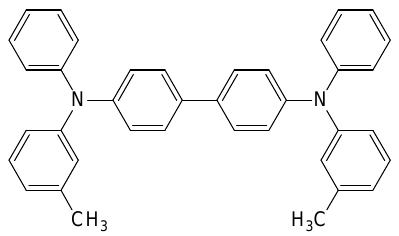
Figure 1. Chemical structure of N,N’-bis(3-methylphenyl)-N,N’-dyphenylbenzidine